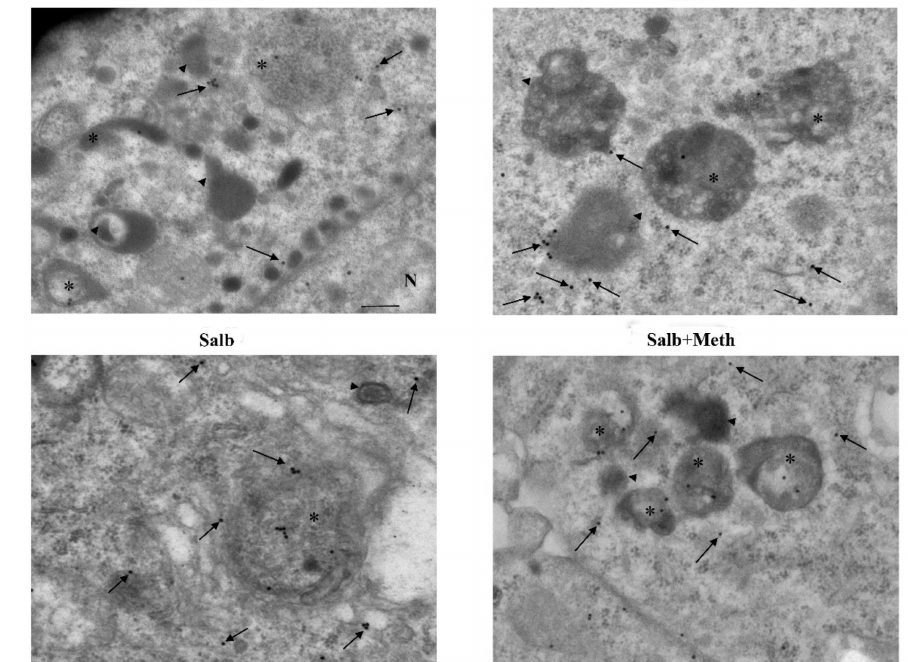
Figure 18. Representative TEM micrograph of LC3 compartmentalization following salbutamol and Meth (high mag- nification). Representative TEM micrographs at high magnification of Control, Meth (50 µ M), salbutamol (5 nM), or salbutamol (5 nM) + Meth (50 µ M)-treated cells. Images show autophagy-like vacuoles (arrowhead); autophagy vacuoles (asterisk for LC3); cytosolic LC3 particles (arrow pointing 20 nM immunogold particles). Cells were fixed for TEM anal- ysis 72 h after Meth administration. In the combined treatment, salbutamol was administered 30 min before with Meth. Scale bar = 200